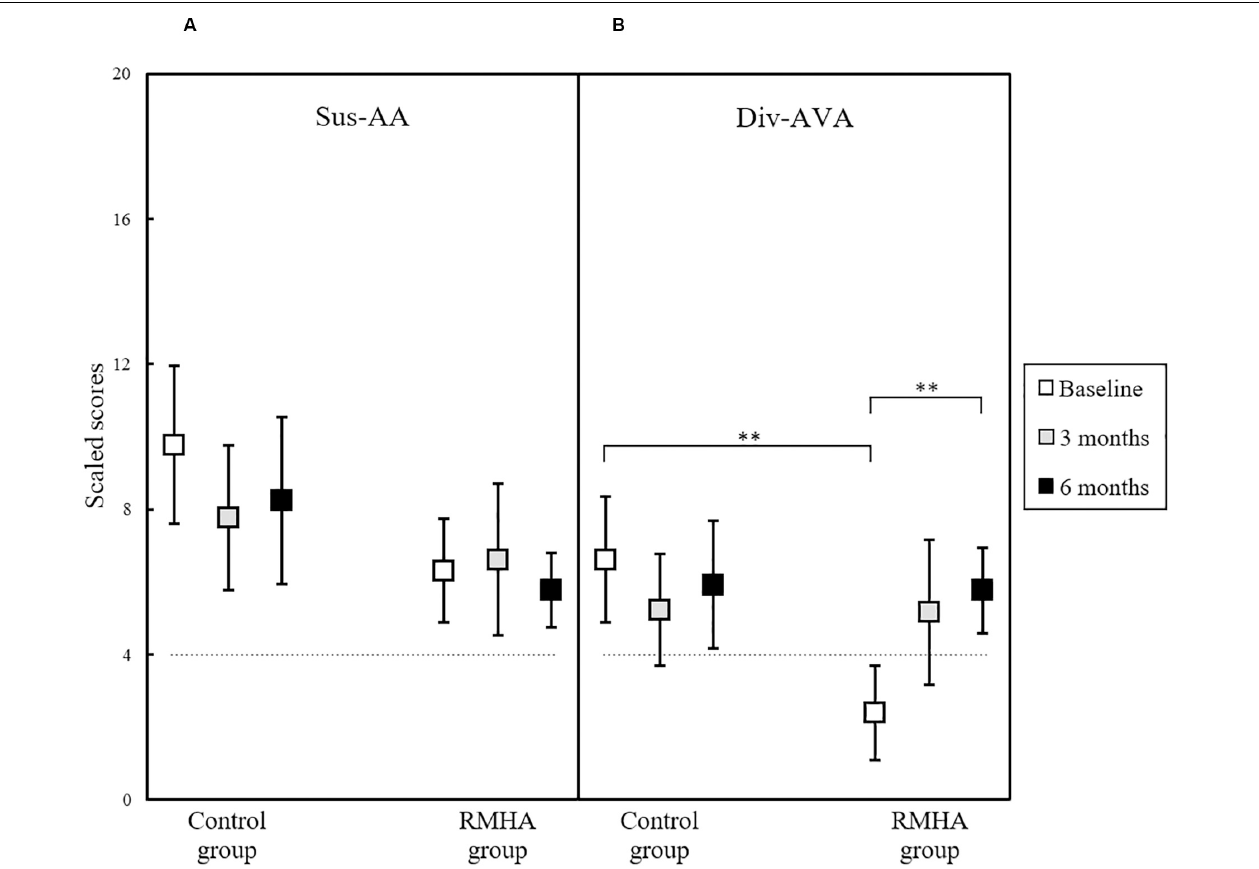
FIGURE 5 | Plots of mean scaled scores in (A) the TEACh Sus-AA subtest, and (B) the TEACh Div-AVA subtest, for 13 controls and 13 RMHA children, at baseline, 3 and 6 months. Error bars represent a 95% CI of the mean. There was a significant difference between the two groups in the Div-AVA baseline scores, and significant difference in the Div-AVA scores of the intervention group from baseline to 6 months. The horizontal dotted line indicates the cut-off for what is considered abnormal performance (i.e., 4 scaled scores and below). CI, Confidence Interval; Div-AVA, Divided Auditory-Visual Attention; RMHA, Remote Microphone Hearing Aid; Sus-AA, Sustained Auditory Attention; TEACh, Test of Everyday Attention for Children. ∗∗ p < 0.01.